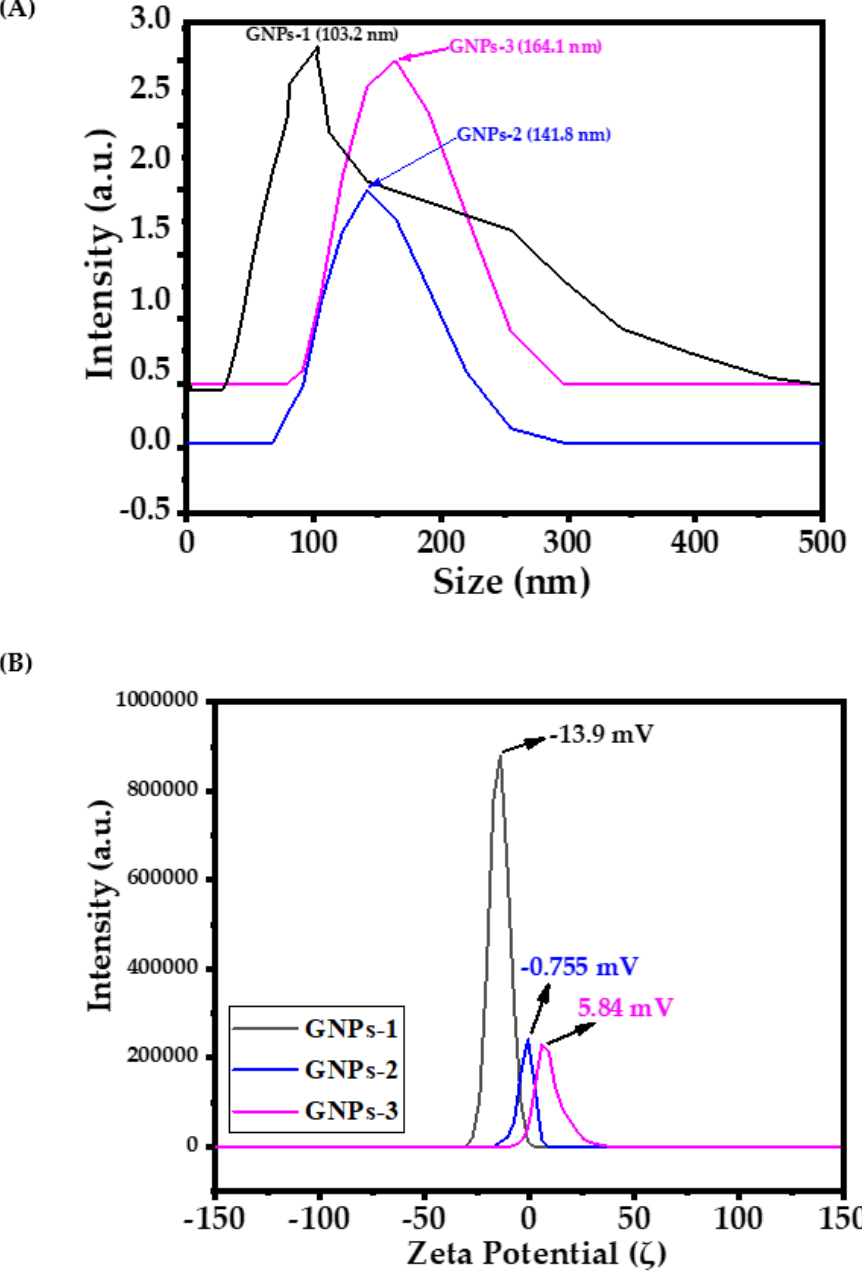
Figure 2. ( A ), dynamic light scattering (DLS) for particle size distribution; and ( B ), represent the zeta Figure 2. A , dynamic light scattering (DLS) for particle size distribution; and B , represent the zeta potential of GNPs-1, GNPs-2, and GNPs-3 potential of GNPs-1, GNPS-2, and GNPs-3 respectively.